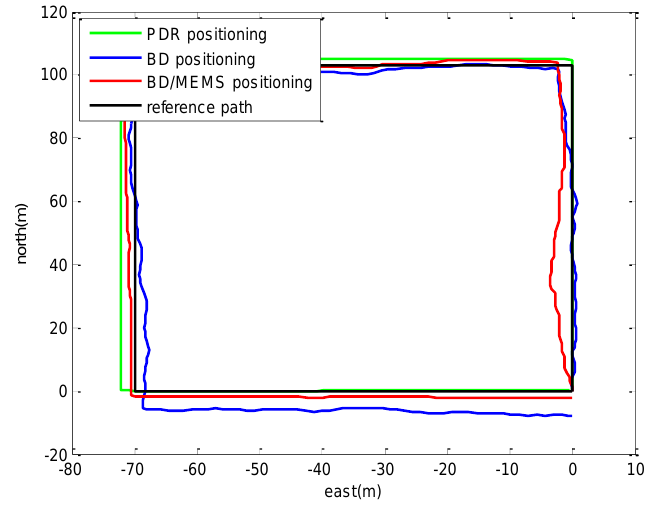
Figure 11. Comparison of the trajectories.